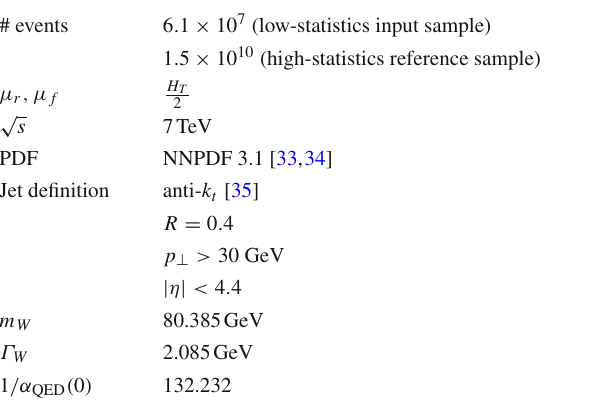
Table 1 Parameters used for event